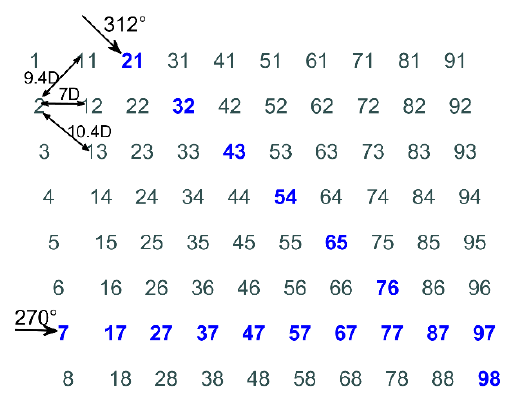
Figure 7. Layout of the Horns Rev I offshore wind farm.